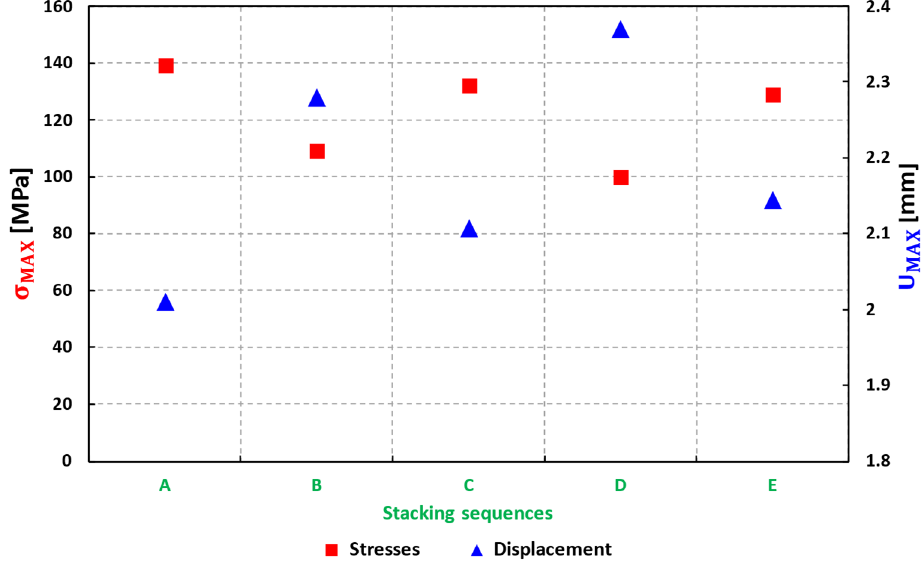
Figure 17. Maximum stresses and displacement curves for different stacking sequences. Table 8. Different combinations of glass–epoxy laminates and comparison of results with aluminum ( S max = 186.581 MPa, U max = 3.150 mm).